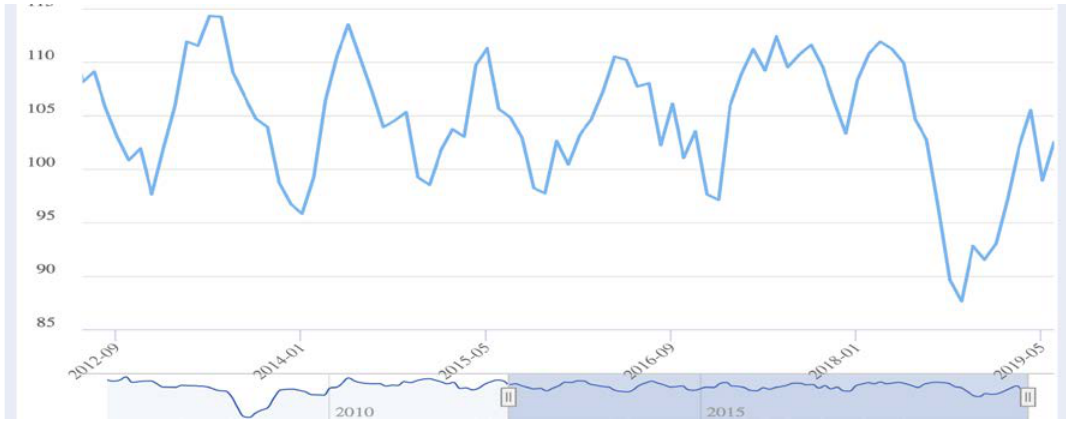
Figure 2. Real Sector Confidence Index: 2012:05-2019:05. Source: CBRT EVDS (2019a). Available at: https://evds2.tcmb.gov.tr/index.php?/evds/serieMarket Access date: